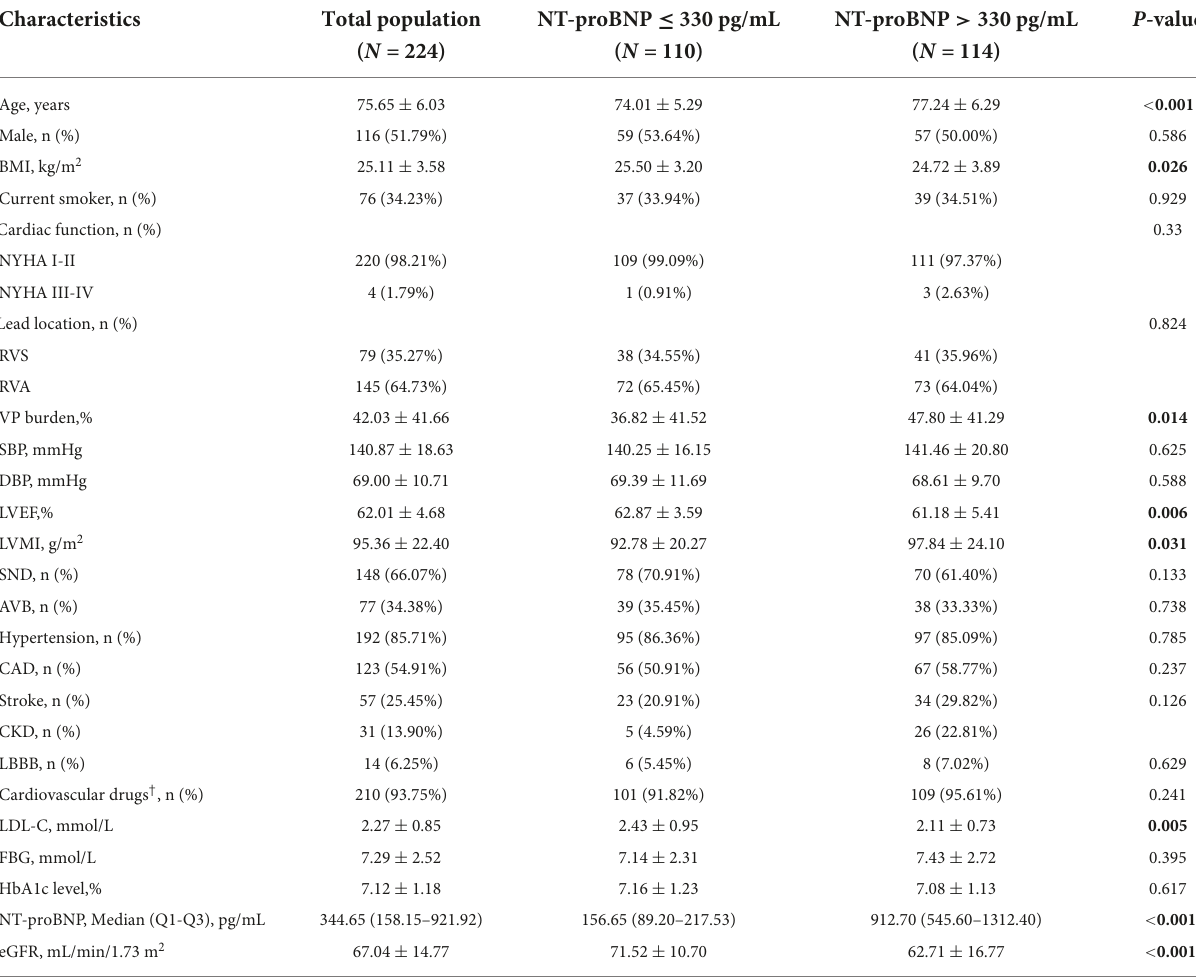
TABLE 1 Baseline characteristics of study participants stratified by